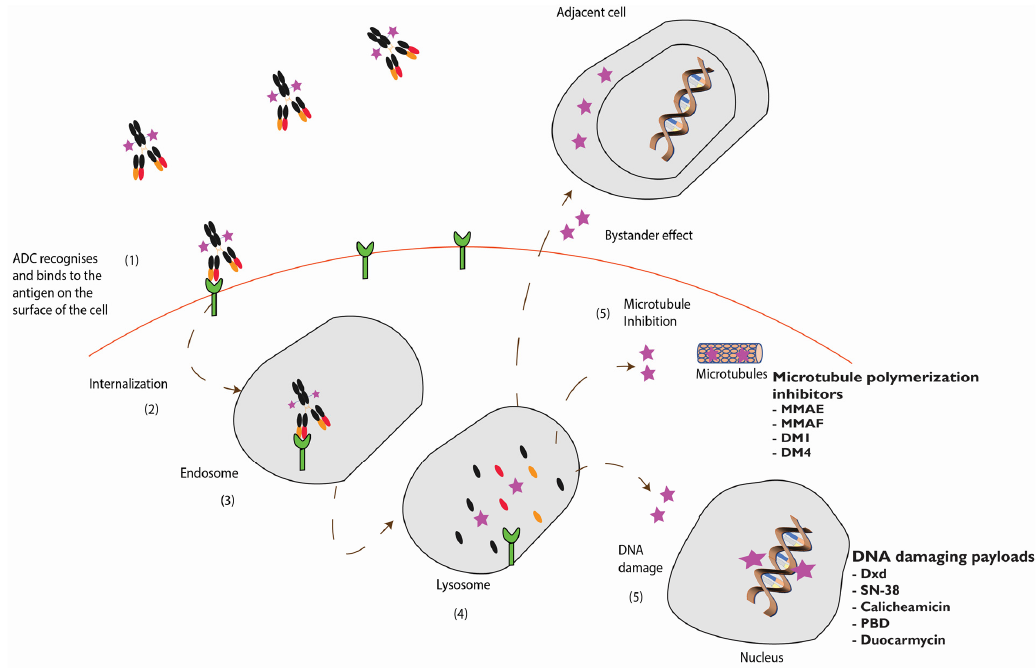
Figure 2. Mechanism of action for ADCs: Once the ADC binds to the antigen (green) ( 1 ), it is then internalized ( 2 ) by a process called receptor mediated endocytosis ( 3 ), it is then cleaved in the lysosome ( 4 ) and the payload is released ( 5 ). Depending on the class of payload (pink), it can either inhibit microtubules ( 5 ) or damage DNA ( 5 ). This free drug is designed to directly kill the antigen positive target cell, it can in some cases diffuse out of the target cell and subsequently kill the surrounding antigen negative cells causing a bystander effect.